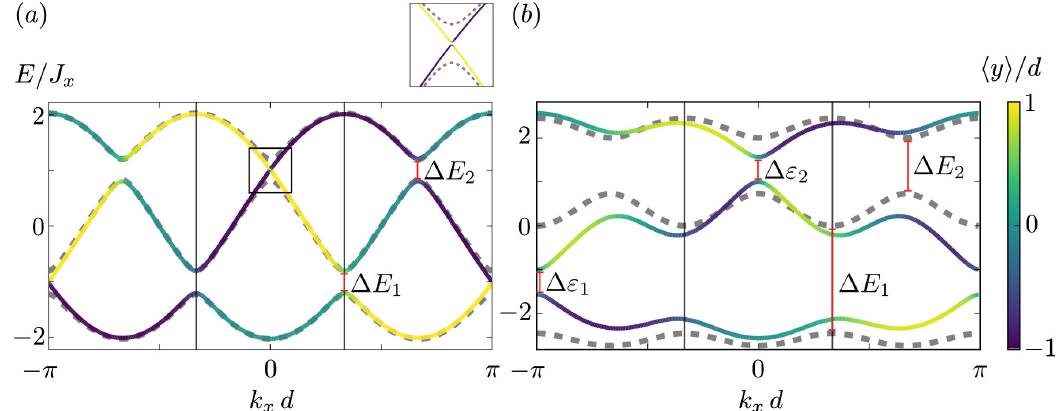
= 3 and flux Φ = 2 π = J / 5, and , for (a) J y y x 3 (cid:28) J y x